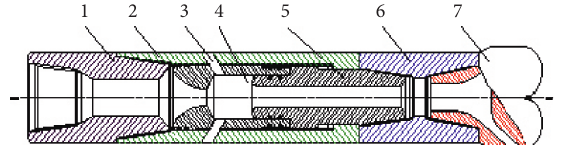
Figure 1: Self-excited pulsed abrasive jet drilling tool. (1) Upper connector; (2) body; (3) drawing entrance; (4) mixing chamber; (5) bit connecting rod; (6) lower connector; (7) drill bit.